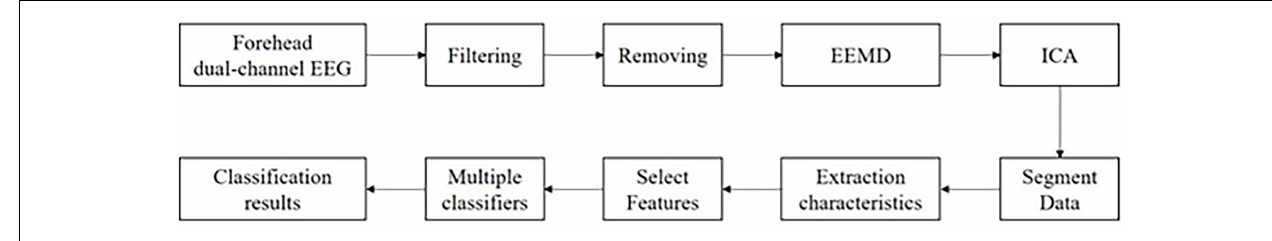
FIGURE 2 | Flow chart of dual-channel emotion classification algorithm.